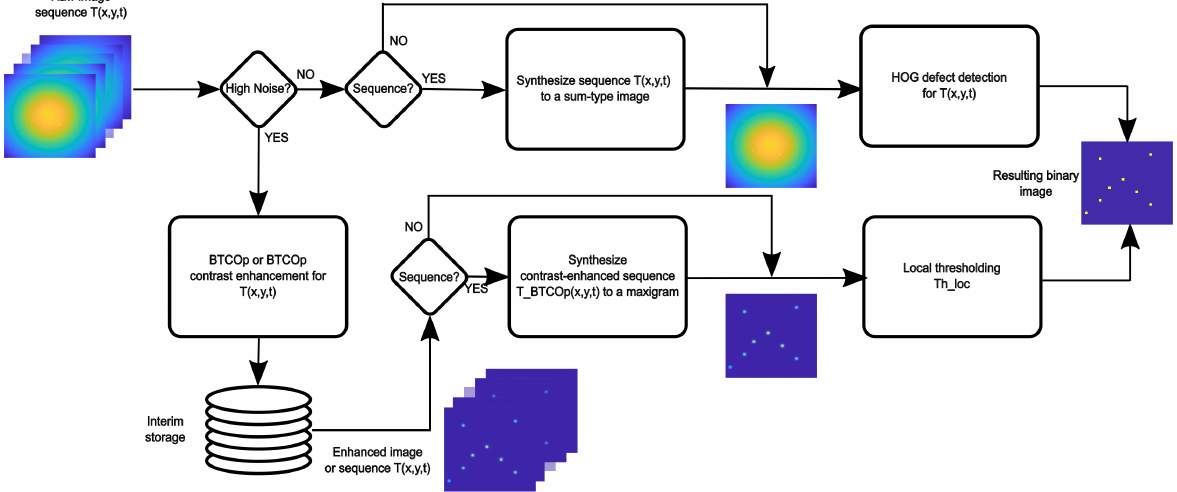
Figure 1. Main steps of the automated defect detection